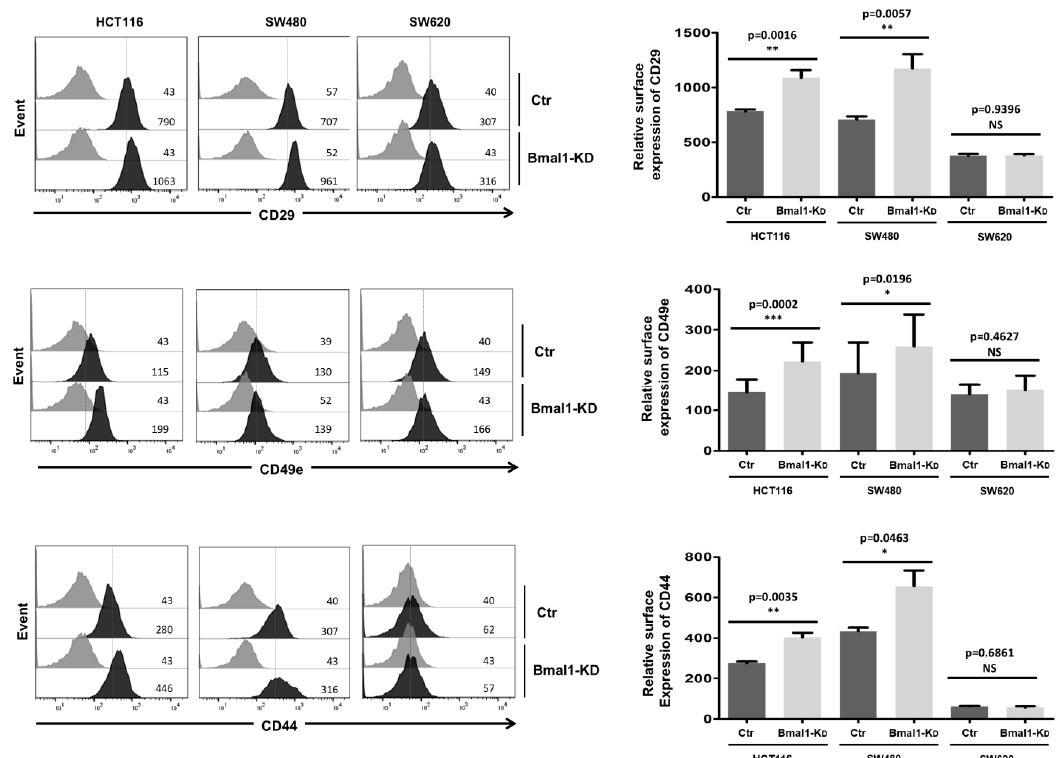
Figure 6. BMAL1-KD increased the expression of cell adhesion molecules on CRC cell lines. Flow cytometry analysis of surface expression of CD29 (integrin β 1), CD49e (integrin α 5), and CD44 adhesion molecules. Left, a representative direct staining of four independent experiments is shown. The dark-colored bars correspond to cells incubated with phycoerythrin (PE)-conjugated antibodies against CD29, CD49e, and CD44, and grey bars correspond to cells incubated with the isotype-matched control antibody. Mean fluorescence intensity values for each marker are shown at the right of each histogram. Right, BMAL1-KD led to increased expression of membranous CD29, CD49e, and CD44, mostly in primary BMAL1-KD CRC cell lines ( n = 3, * p < 0.05, ** p < 0.01, *** p < 0.001). Data are shown as means ± SEM.